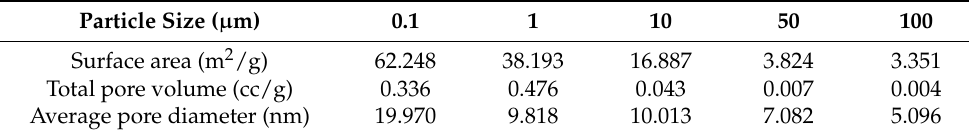
Table 1. Surface area, total pore volume, and average pore diameter of PS-MPs. Particle Size ( µ m) 0.1 1 10 50 100 Surface area (m 2 /g) 62.248 38.193 16.887 Total pore volume (cc/g) 0.336 0.476 0.043 0.007 Average pore diameter (nm)